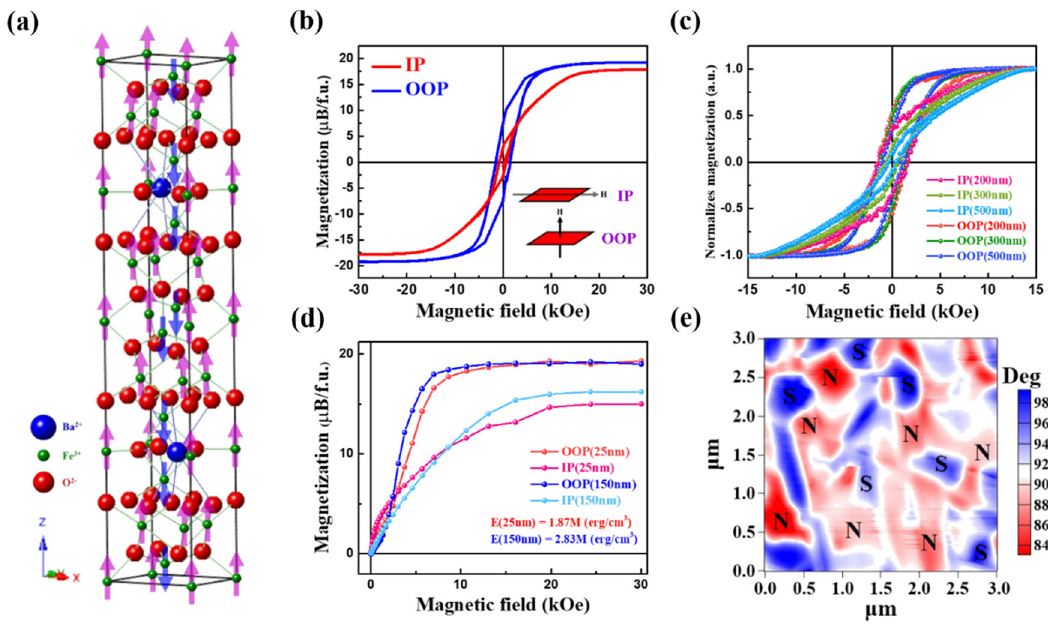
Fig. 2 Magnetic properties. a Schematic of BaM magnetic structure. b Hysteresis loops showing the characteristic of PMA. c IP and OOP hysteresis loops with different thicknesses. d Calculation of intrinsic anisotropy energy density with fi lm thicknesses of 25 nm and 150 nm. e MFM